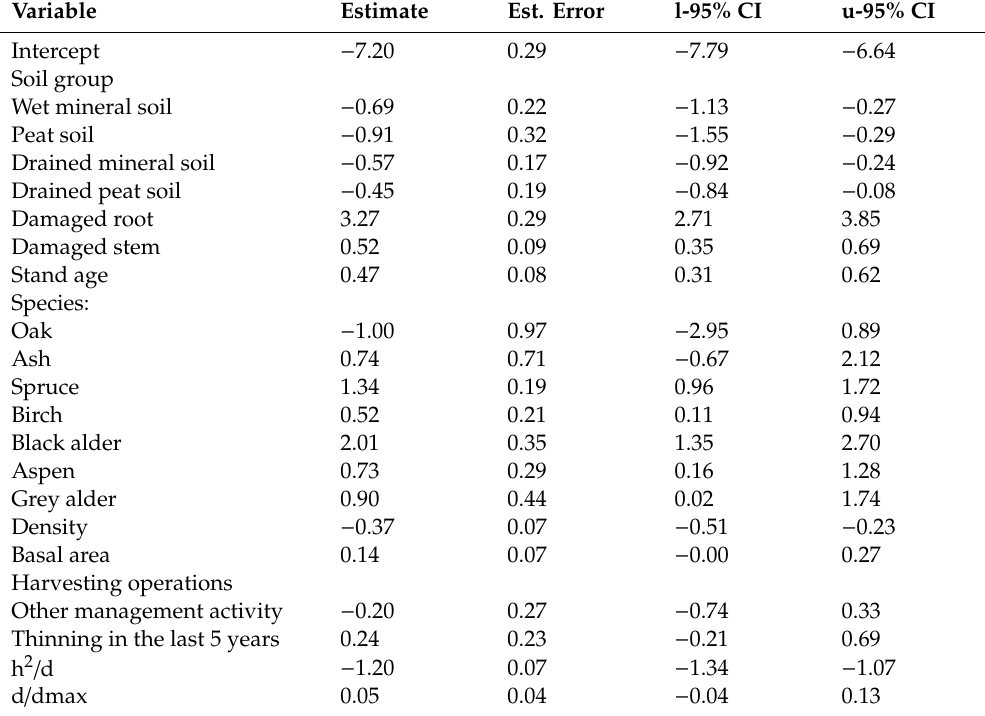
Table 3. Estimates and credibility intervals of the full generalised linear mixed-e ff ects model (GLMM) model. Est. Error—SD of posterior distribution; CI—lower and upper limits of the credibility interval. For the factor variables, the estimate shows a di ff erence to the reference level (dominant tree species—pine, management—none, soil group—dry mineral